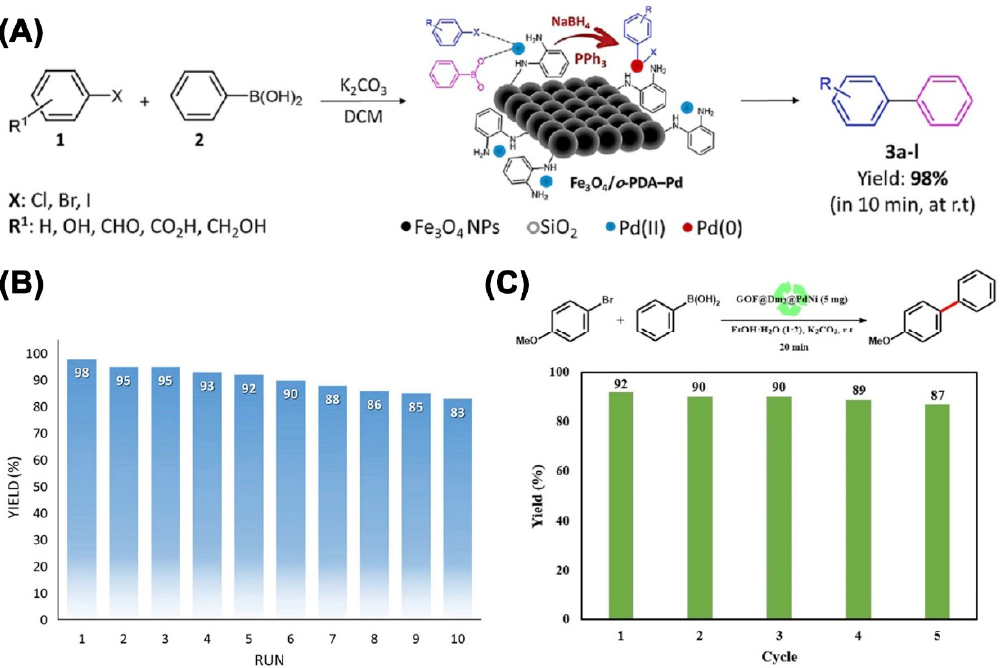
Figure 12. ( A ) Schematic of a Suzuki–Miyaura coupling reaction catalyzed by Pd@Fe 3 O 4 /SiO 2 and ( B ) reusability tests [132], Copyright 2020 Elsevier. ( C ) Reaction mechanism and recycling